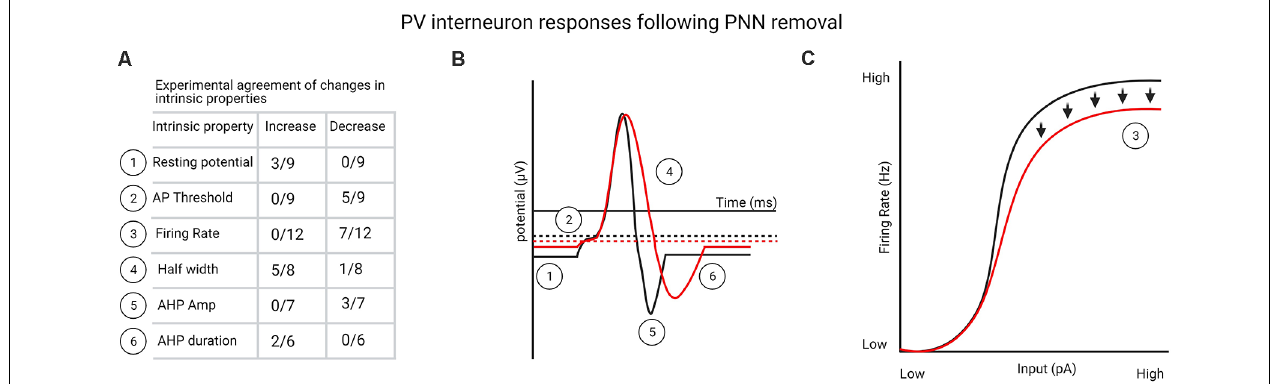
FIGURE 1 | (A) List of perineuronal net (PNN) removal-mediated changes in parvalbumin (PV) interneuron intrinsic properties that one-third or more of the experiments agreed upon (see Supplementary Table 1 for a complete list of studies). (B) Graphical representation from table shown in (A) of changes in PV interneuron intrinsic properties following PNN removal. (C) Experimentally agreed upon firing rate changes to PV interneurons following PNN removal, indicating deficits in firing rate at high stimulation levels. Created with